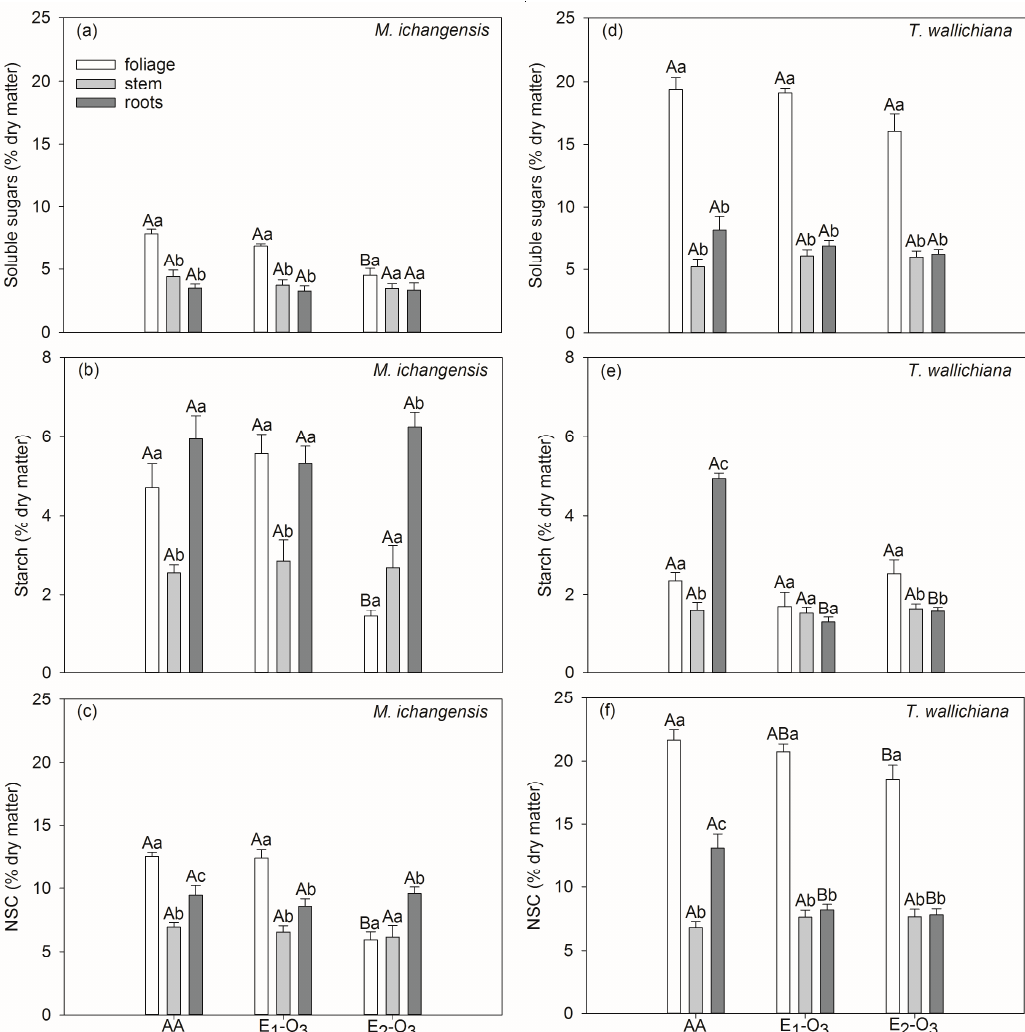
Figure 3. Soluble sugars ( a , d ), starch ( b , e ), and non-structural carbohydrate (NSC) concentrations ( c , f ) in individual tissues of M. ichangensis ( a – c ) and T. wallichiana ( d – f ) under different O 3 fumigation treatments. Different capital letters indicate a significant difference between O 3 fumigation treatments for the same tree tissues ( p < 0.05), and different lower-case letters indicate a significant difference between different tissues within the same species under the same O 3 fumigation treatments ( p < 0.05). Bars indicate standard error of the mean ( n = 3).